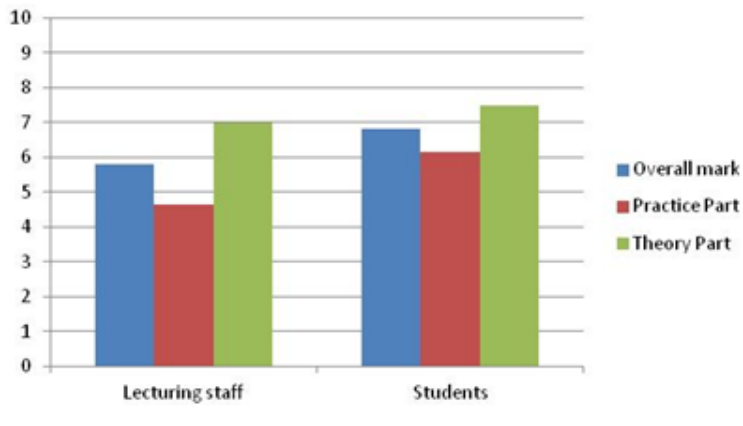
Figure 2. Average mark of the test with practice and theory